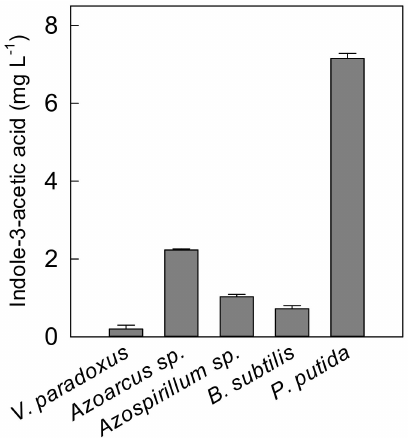
Figure 5. Indole-3-acetic acid (IAA) concentration produced by each bacteria strain in its respectively culture at OD 600 =